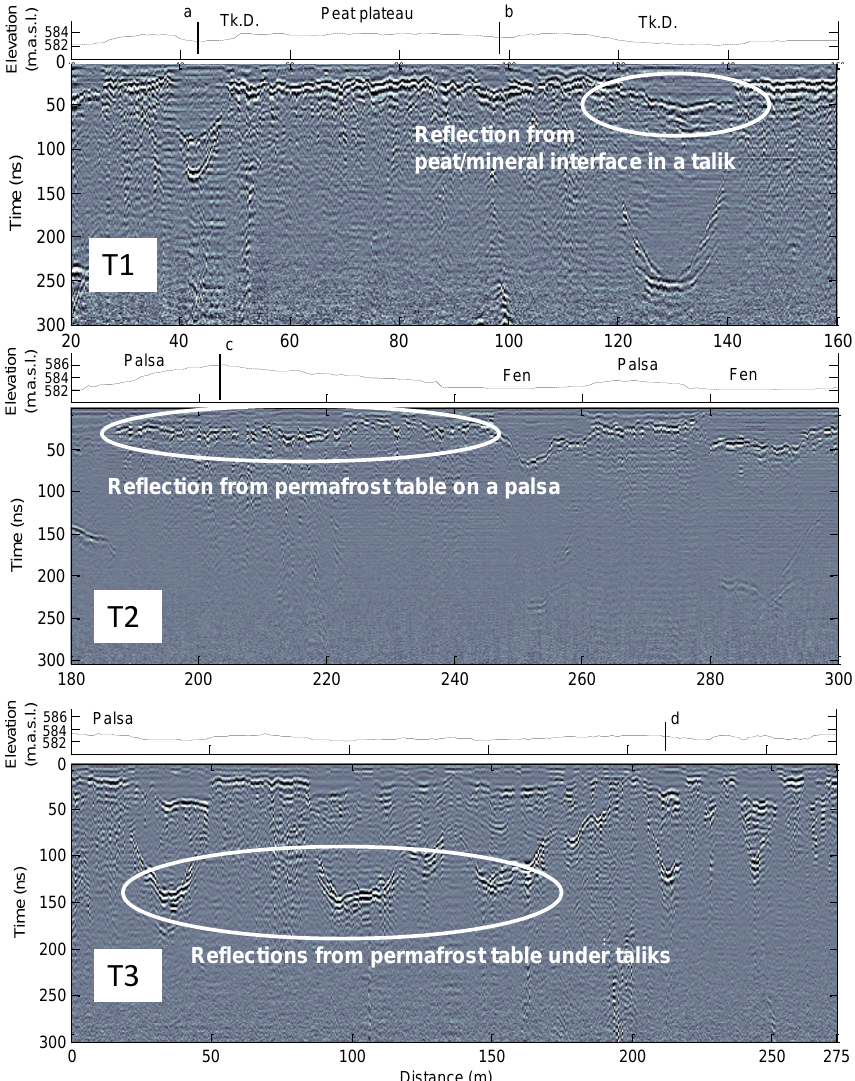
Figure 4. Elevation profiles and GPR images for T1, T2, and T3 with selected reflections marked as examples of interfaces that were identified for this study. Landforms are indicated on top of elevation profiles along T1 and T2 (Tk.D is thermokarst depression) together with coring points in T1 (a is point 3 in Fig. 1, and b is point 4 in Fig. 1) and T3 (d is point 6 in Fig. 1) as well as the 10m borehole in T2 (c is point 1 in Fig. 1). No landforms are indicated along T3 after the first palsa (0–25m) due to the complex micro topography of hummocks and thermokarst depressions along this